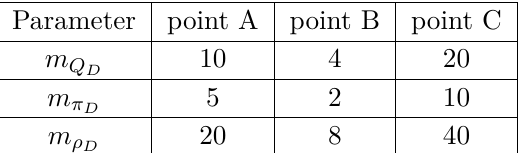
Table 2. Summary of the different benchmark points.